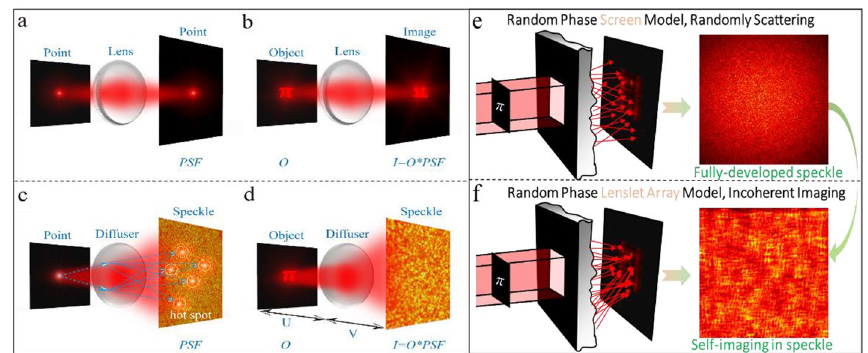
Fig. 2 Operational principles of diffuser-lens imaging systems. The schematic of ( a ) the PSF for ( b ) the lens imaging system. ( c ) The ‘hot-spot’ effect in the diffuser imaging speckle, and ( d ) the imaging model and experimental setup for incoherent illumination. ( e-f ) Random phase screen model ( e ) without features of phase distribution, and ( f ) with lenslet array phase features. The speckle in ( e ) is generated by calculating the light-propagation through phase-screen [38]. The speckle in ( f ) is generated considering the lenslet-phase with incoherent-imaging model using Eq.